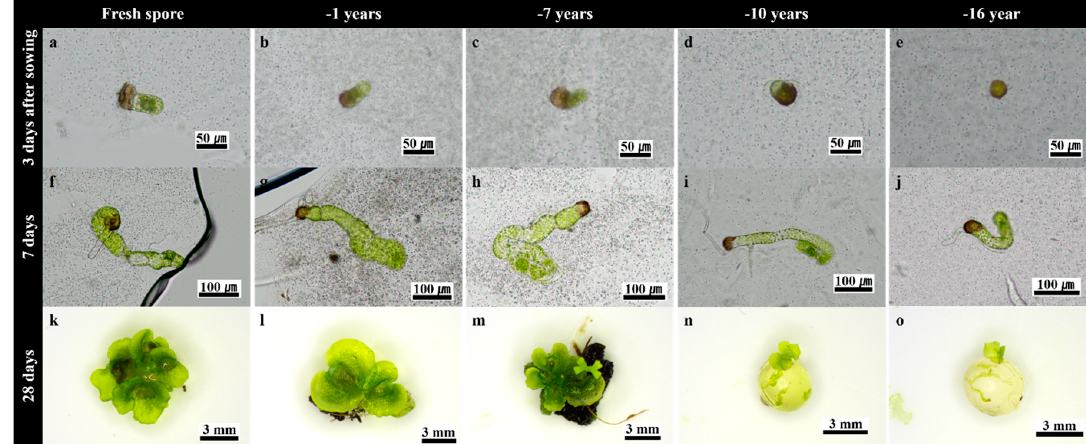
Figure 1. Gametophyte development and response of SFS (synthetic seeds using fern spores) produced with bracken spores stored for different periods at 4 °C: ( a – e ) germinated spores 3th day after sowing; ( f – j ) germinated spores 7th day after sowing; ( k – o ) germinated spores 28th day after sowing. Table 3. Sporophyte formation and growth of SFS (synthetic seeds using fern spores) produced with bracken spores stored for different periods at 4 °C.